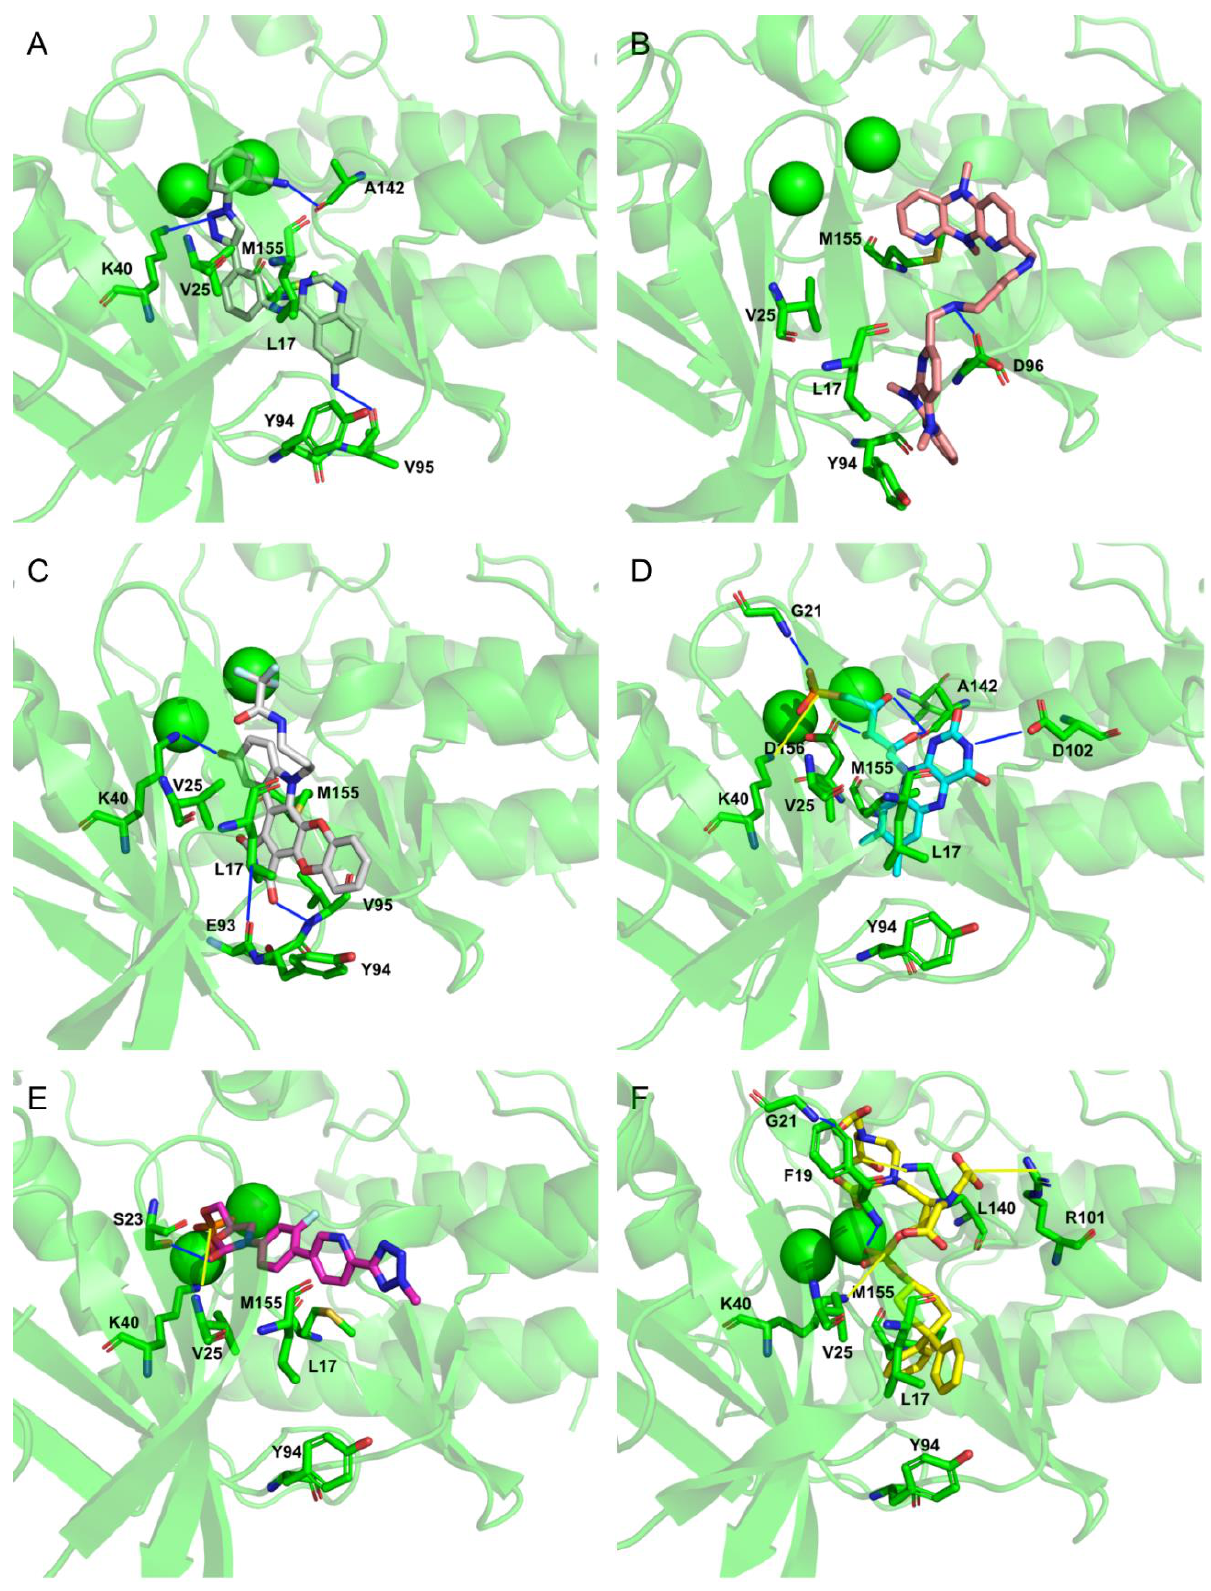
Figure 8. Representation of the Interactions of CMLDID2468 ( A ), AB-00011214 ( B ), AB-00014564 ( C ), Riboflavin Monophosphate ( D ), Tedizolid Phosphate ( E ) and Gadofosvese ( F ) bound to PknB. Figures were produced using Pymol.